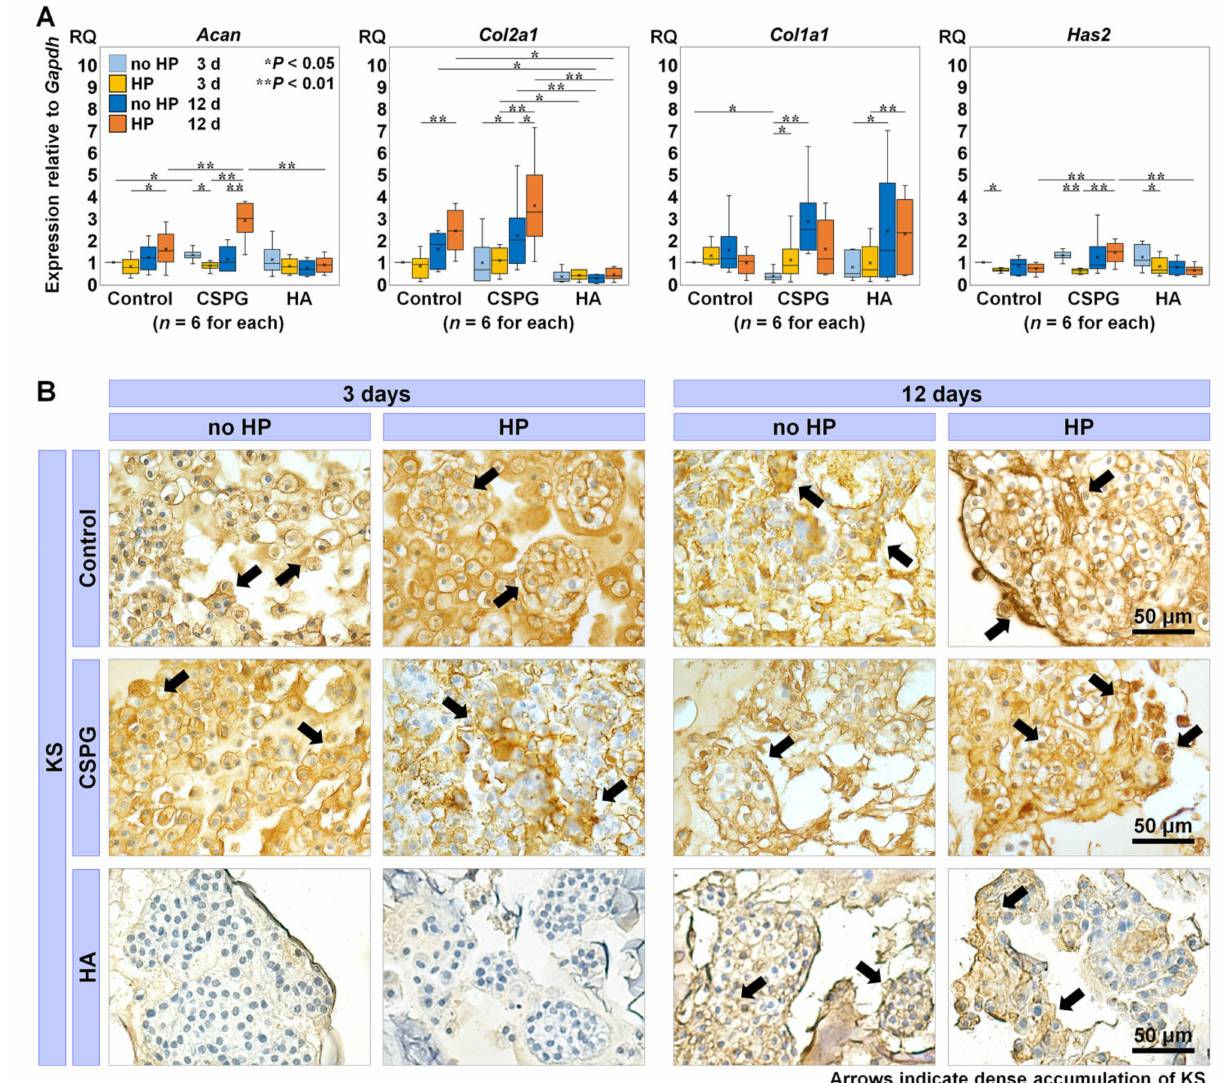
Figure 1. The effects of augmenting extracellular matrix (ECM) on metabolism in bovine nucleus pulposus (bNP) cells under hydrostatic pressure (HP). ( A ) Gene expression of aggrecan core protein ( Acan ), collagen type II and I ( Col2a1 and Col1a1 ), hyaluronan synthase 2 ( Has2 ) with the no-material control, chondroitin sulfate proteoglycan (CSPG), and hyaluronan (HA) under no HP and HP at 3 and 12 days relative to the control under no HP at 3 days ( n = 6 for each). Data are presented with box plots. Multi-way repeated measures analysis of variance (ANOVA) with the Bonferroni post hoc test was used. * p < 0.05 and ** p < 0.01. Gapdh , glyceraldehyde 3-phosphate dehydrogenase . RQ, relative quantity. ( B ) The accumulation of keratan sulfate (KS) in brown counterstained with hematoxylin. Arrows indicate intense accumulation, each section is 7 µ m thick, and the bar indicates 50 µ